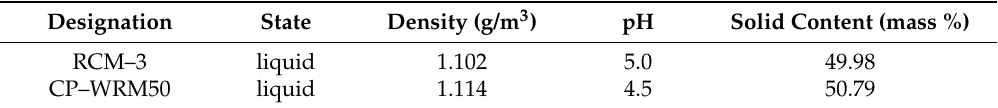
Table 3. Characteristics of chemical admixtures.